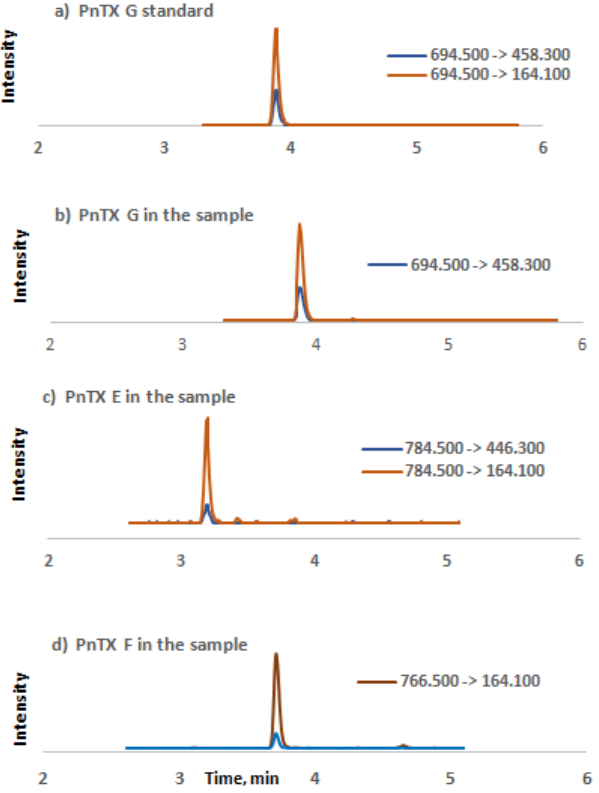
Figure 3. Multiple reaction monitoring (MRM) chromatograms of the PnTX G ( a , b ), PnTX E ( c ), and PnTX F ( d ) found in this study. All chromatograms of the samples were obtained from the nonhydrolyzed extract of bivalve Atrina vexillum from Inhaca Island (South of Mozambique).